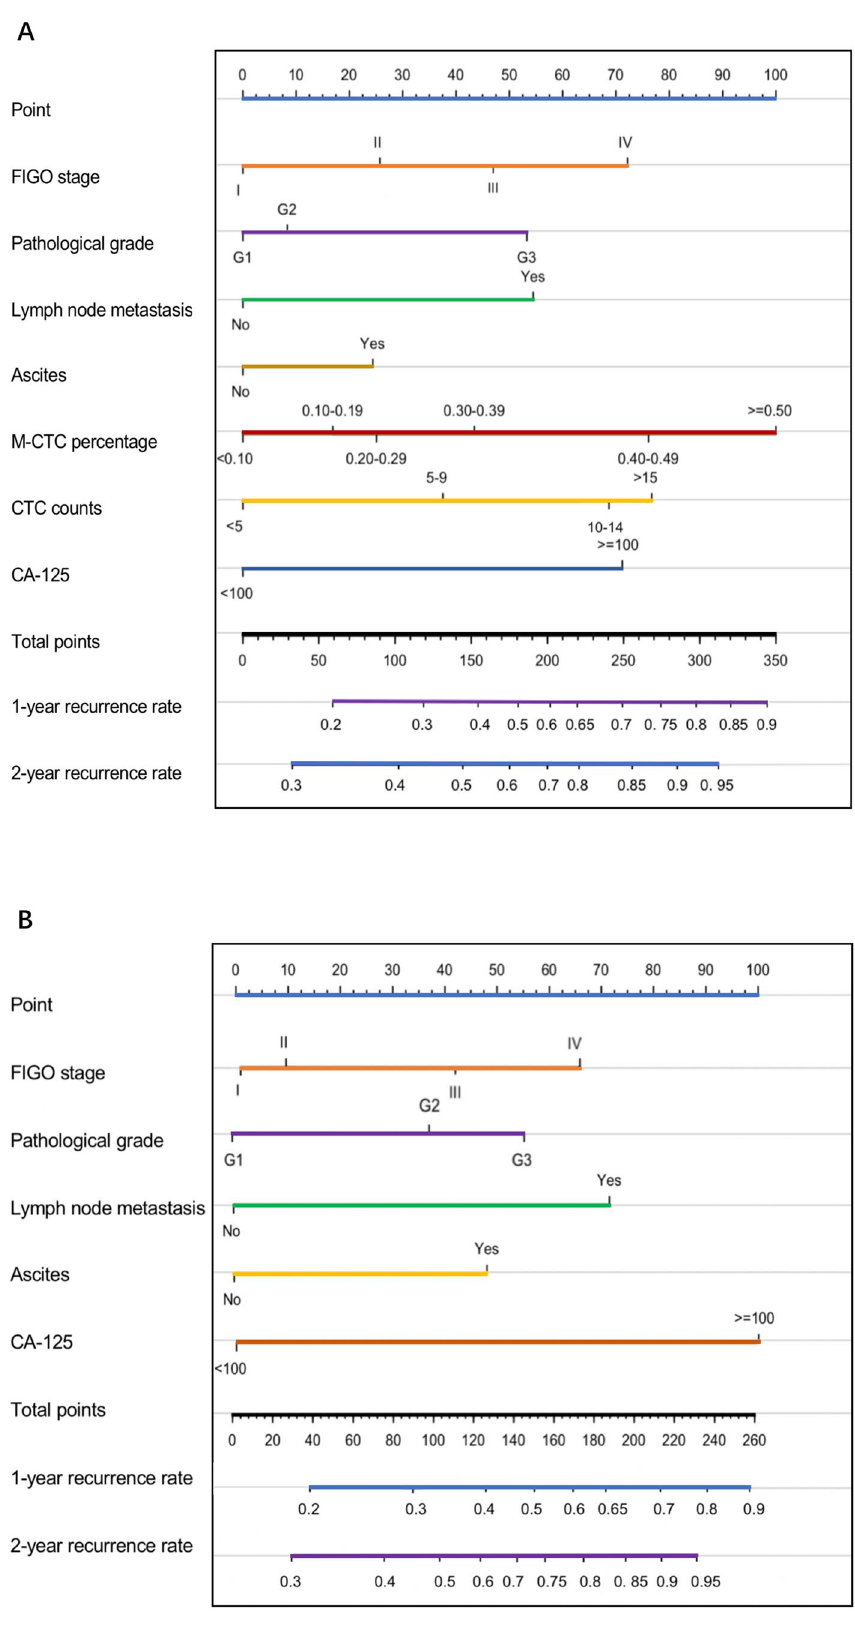
Figure 2. The nomogram models 1-year recurrence rate and 2-year recurrence rate of ovarian cancer patients ( A ) based on CTC counts and M-CTC percentage; ( B ) without CTC counts and M-CTC percentage. The nomogram plots were generated by the “rms” package of R software 18